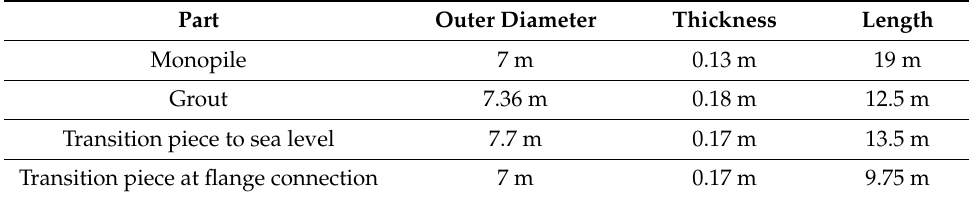
Table 5. The geometrical properties.